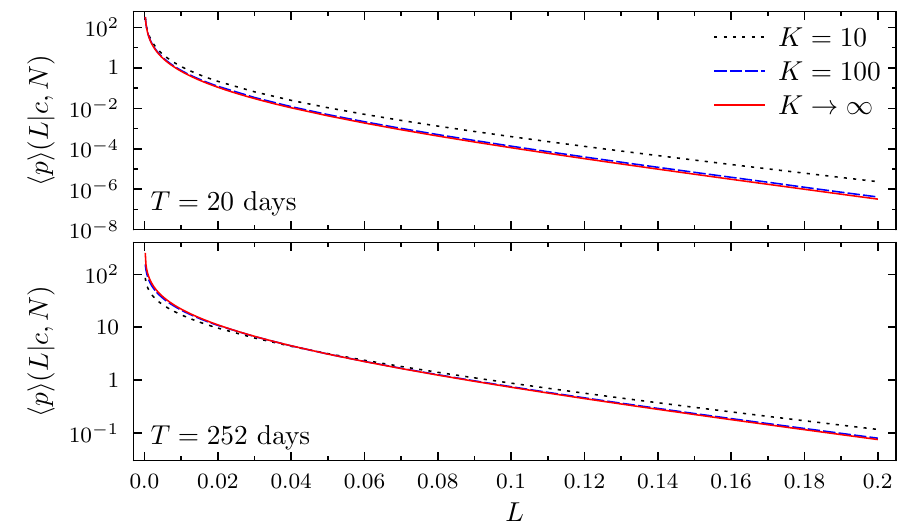
Figure 7. Average portfolio loss distribution for different portfolio sizes of K = 10, K = 100 and ∞ . At the top , the maturity time is one month; at the bottom , it is one year. the limiting case K → Reproduced with permission from (Schmitt et al. 2015), Infopro